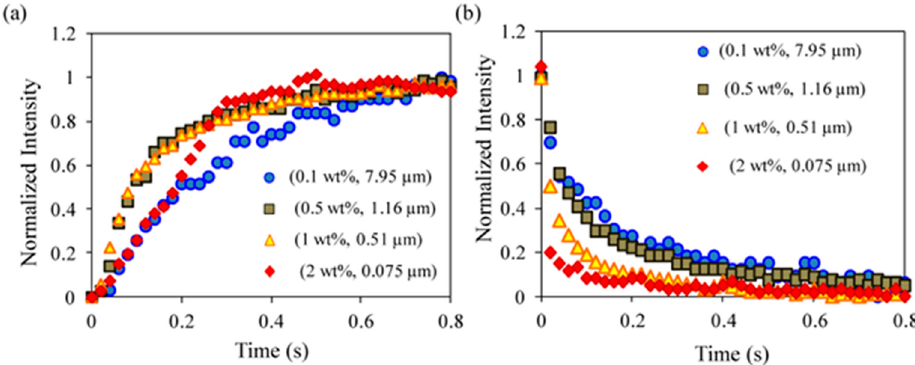
Figure 14. Response times of the aqueous dispersions shown in Fig.11d. ( a ) on-time ( b ) off-time. Adapted with permission from ref. [39], The Optical Society.